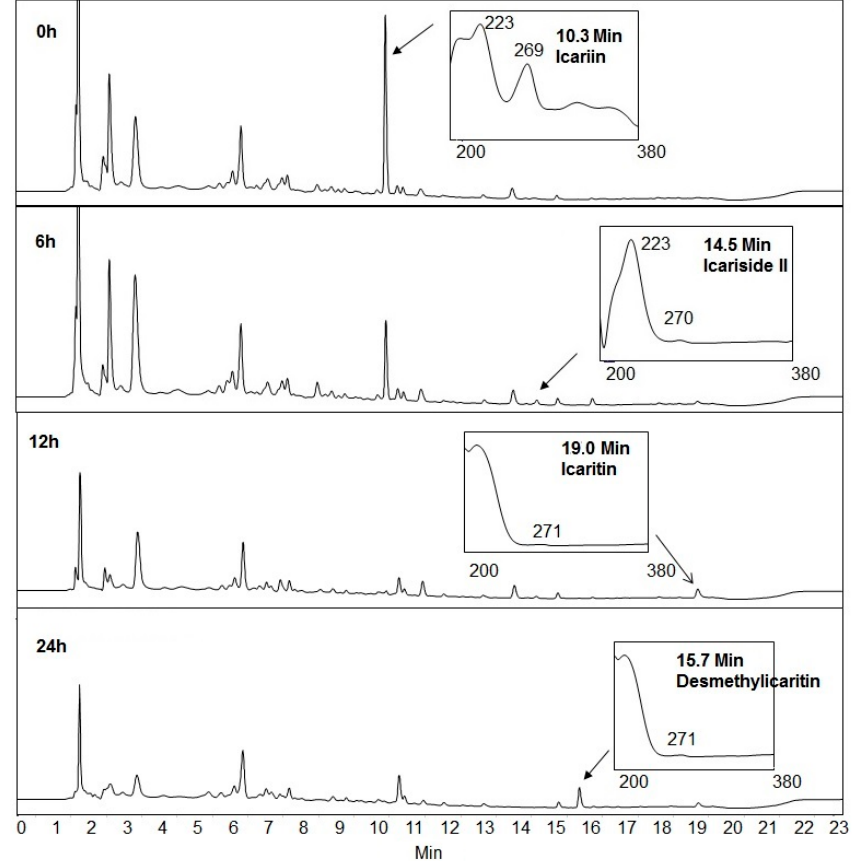
Figure 4. HPLC chromatogram changes at 270 nm absorption over icariin metabolism by Blautia sp. MRG-PMF1.